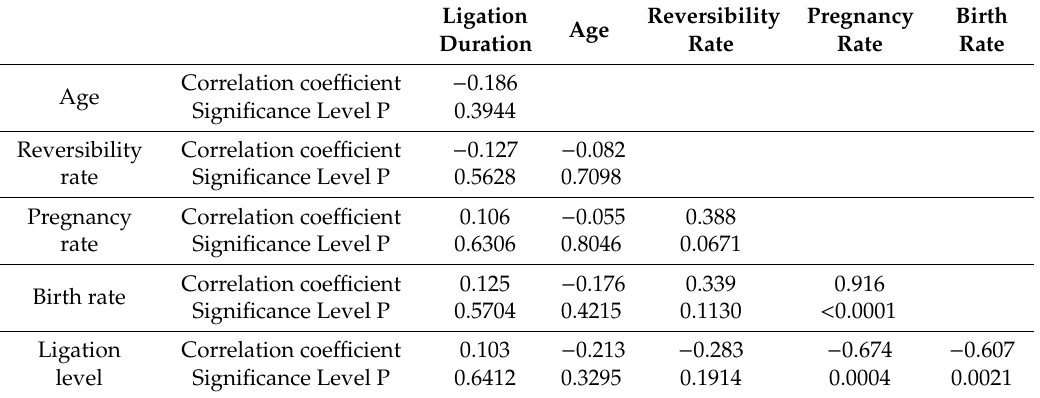
Table 4. Correlations between age group and reversibility rate, pregnancy rate, birth rate and ligation level for the patients aged 35–39.